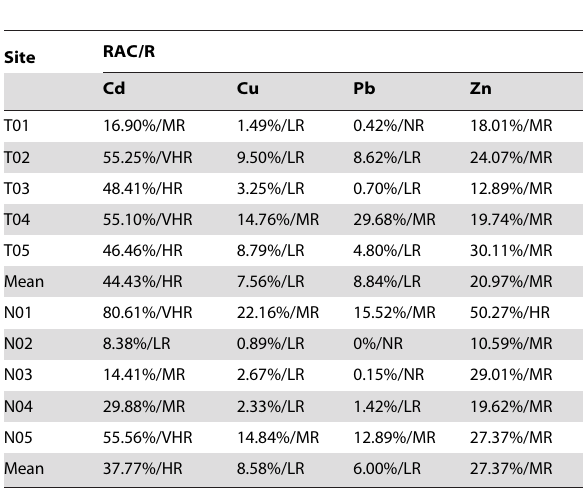
Table 6. Risk assessment codes of heavy metals in soil and